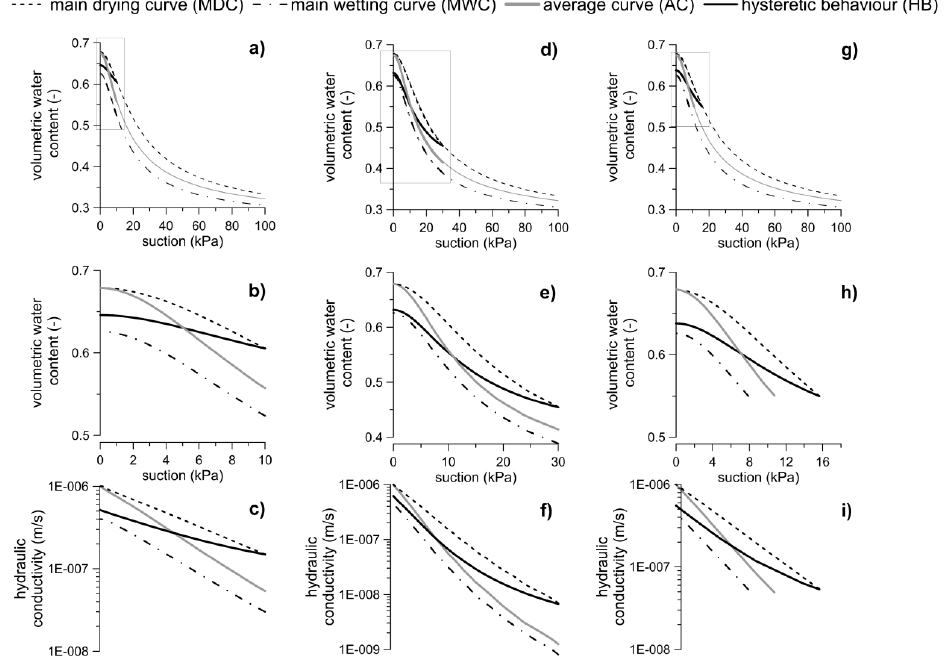
Figure 8. First and second row : volumetric water content – suction ( s –θ ) plane; third row : suction – hydraulic conductivity ( s – k ) plane. Black dashed line: main drying curve; dot-line hatching: main wetting curve; continuous grey line: average curve; black line: scanning paths; thick lines: paths followed in the numerical experiments. First column : hydrostatic initial condition with 10 kPa at 1.5 m. Second column : hydrostatic initial condition with 30 kPa at 1.5 m. Third column : constant volumetric water content (0.55).